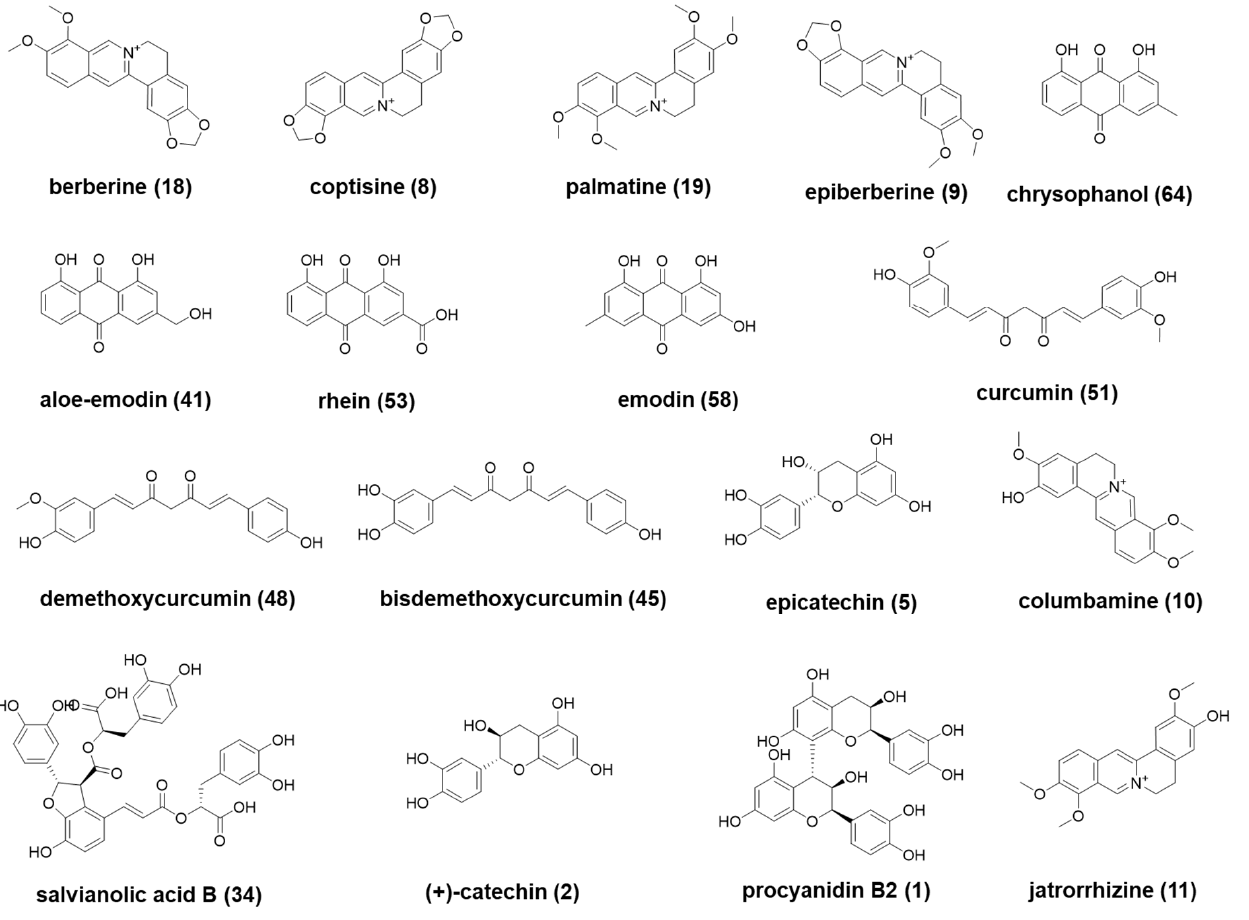
Figure 6. Structures of 17 reference compounds used in this study.